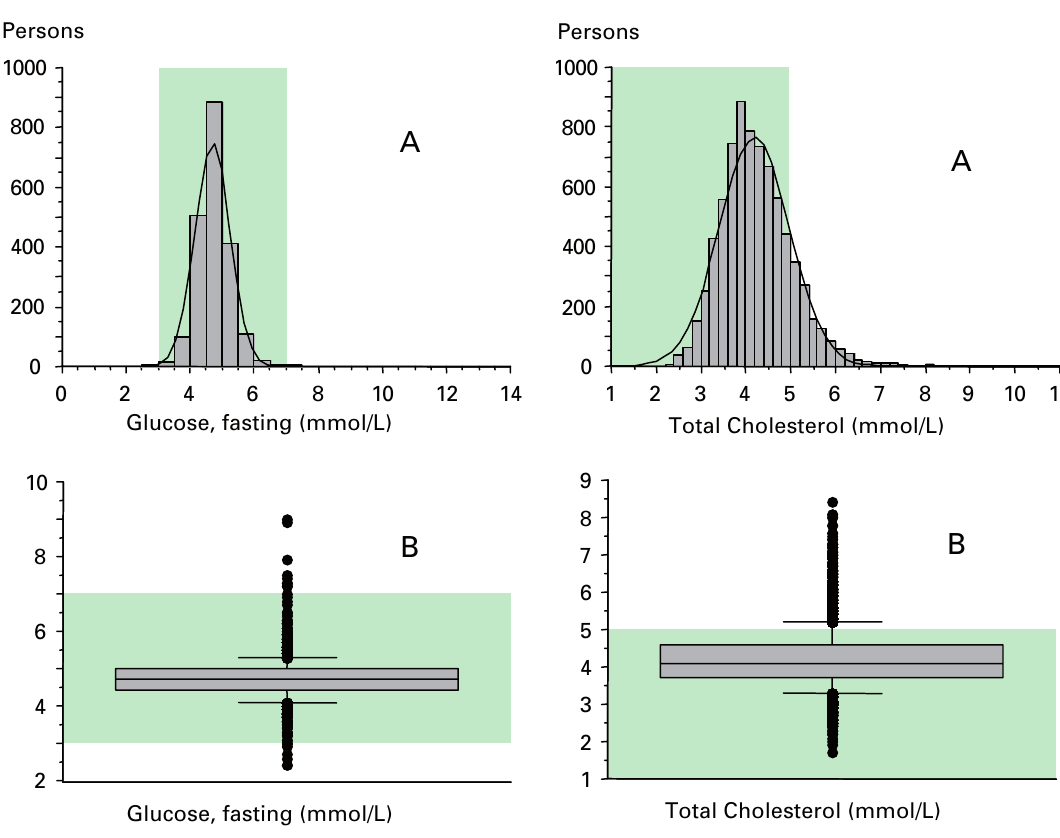
Figure 9 Hypercholesterinemia in young adult males. In contrast to most other parameters cholesterol levels were not distrib- uted normally (A). A very substantial portion of draftees had cholesterol levels above the reference values (A+B), and 1.4% (103/7485) had cholesterol levels above 6.2 mmol/L (B). The area shaded in green indicates the normal